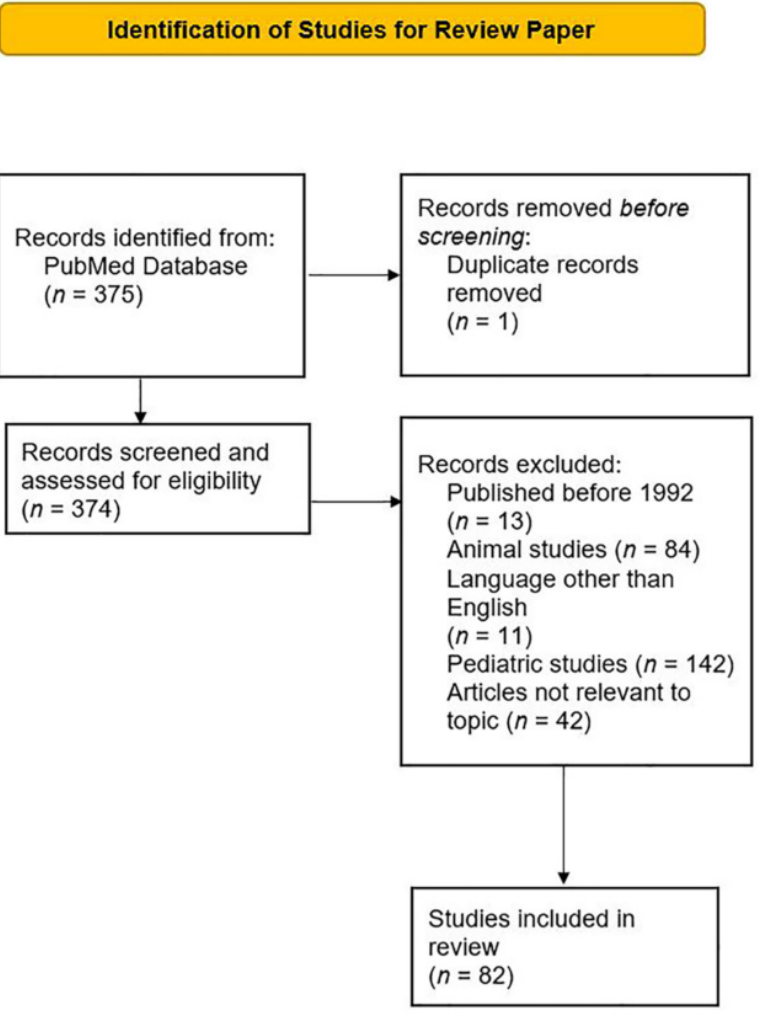
Figure 1. PRISMA flow diagram of literature search and study selection for review.